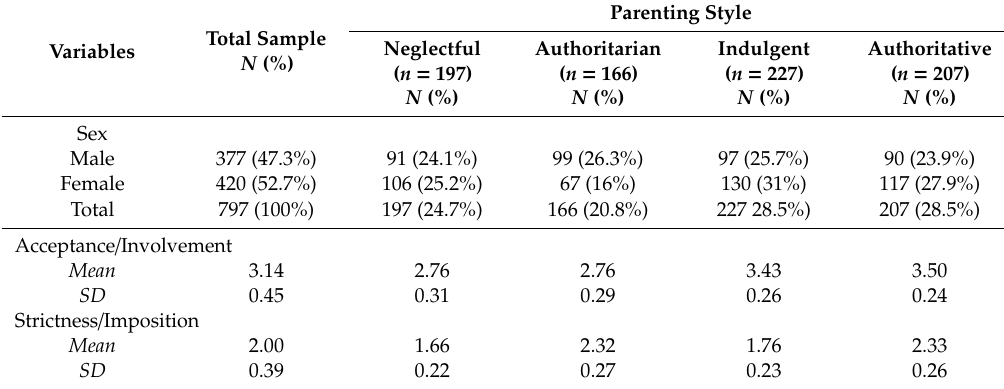
Table 1. Numbers of cases in parenting style groups, as well as mean scores and standard deviations on measures of parental dimensions.